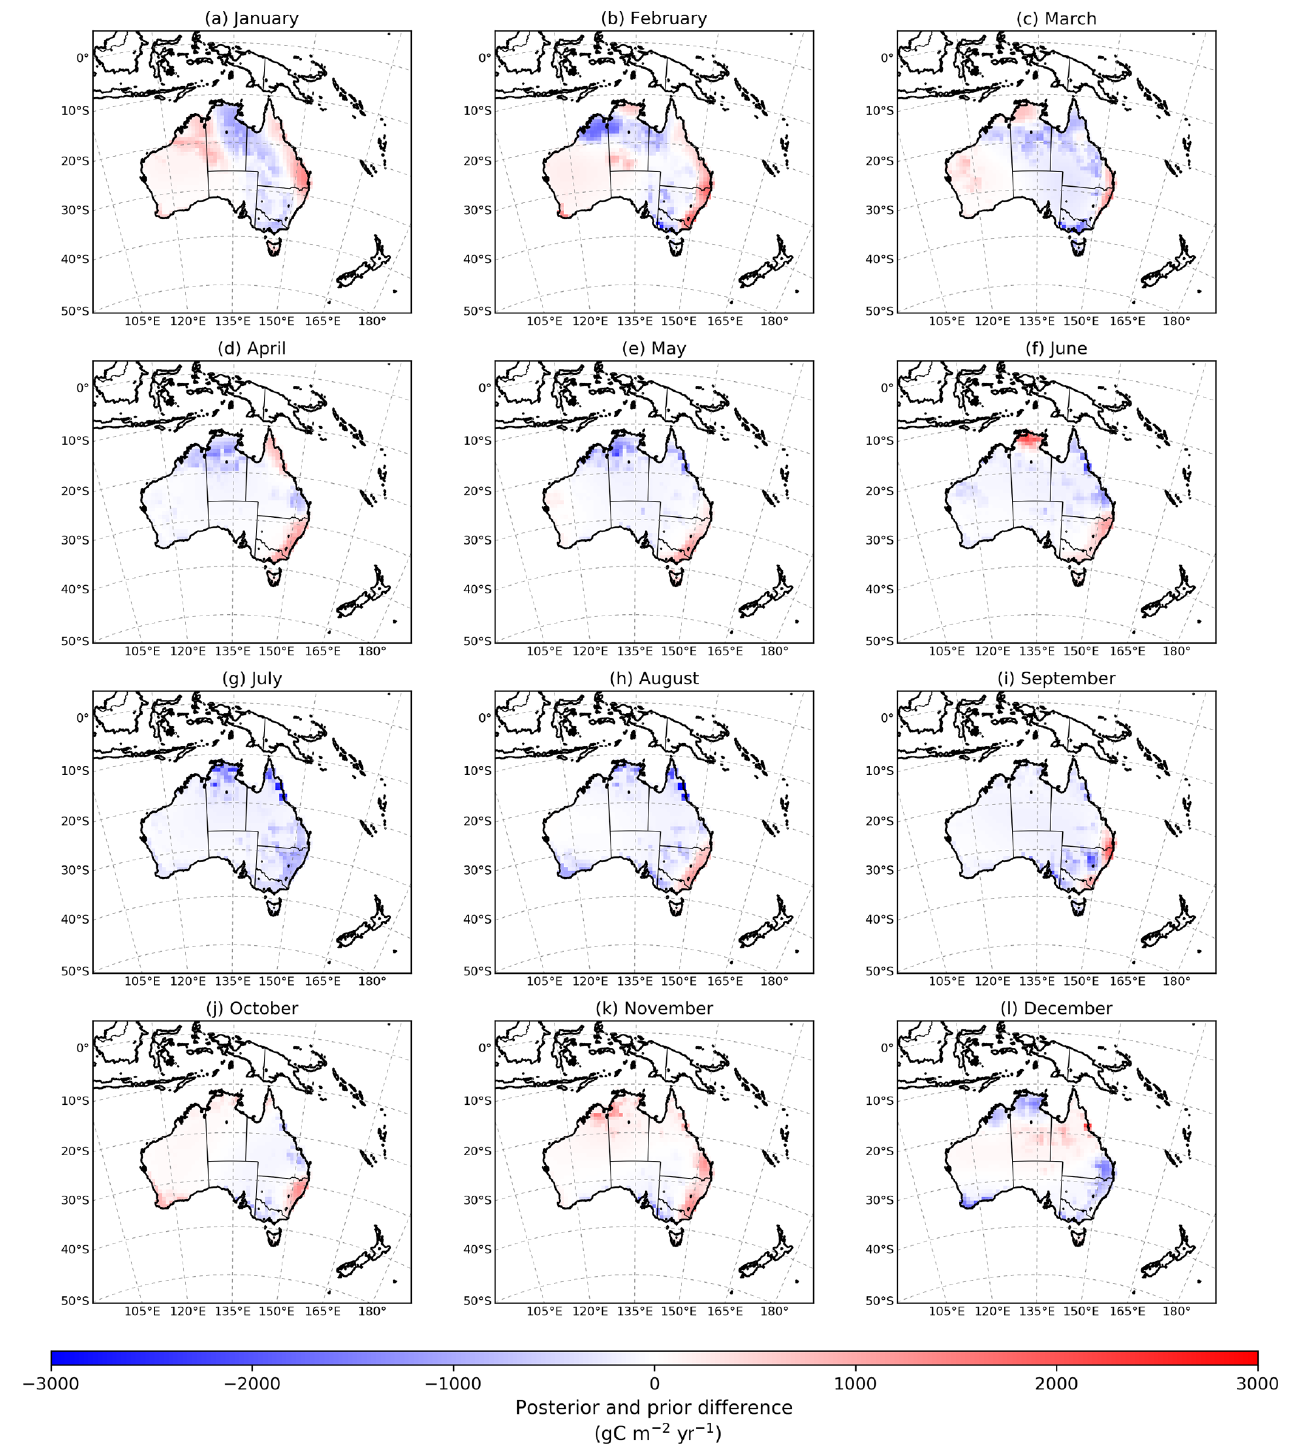
Figure A1. Spatial pattern of the differences between posterior and prior fluxes for